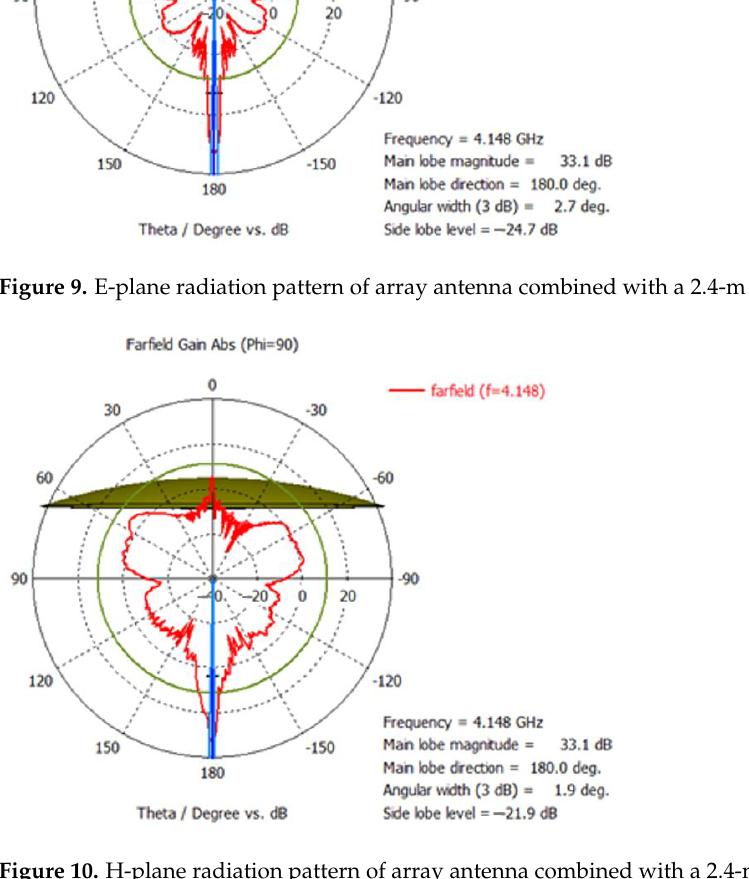
Figure 10. H-plane radiation pattern of array antenna combined with a 2.4-m parabolic reflector. Table 1. Comparison of microstrip antennas in